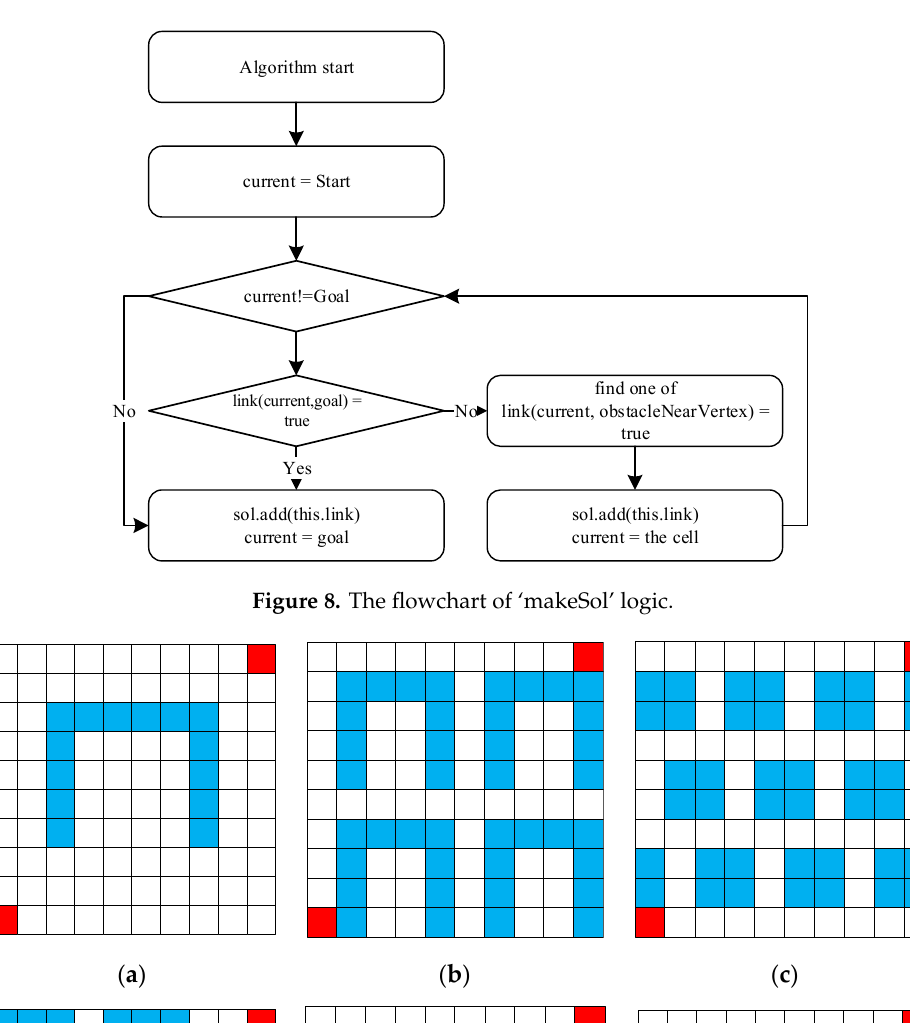
Figure 8. The flowchart of ‘makeSol’ logic.